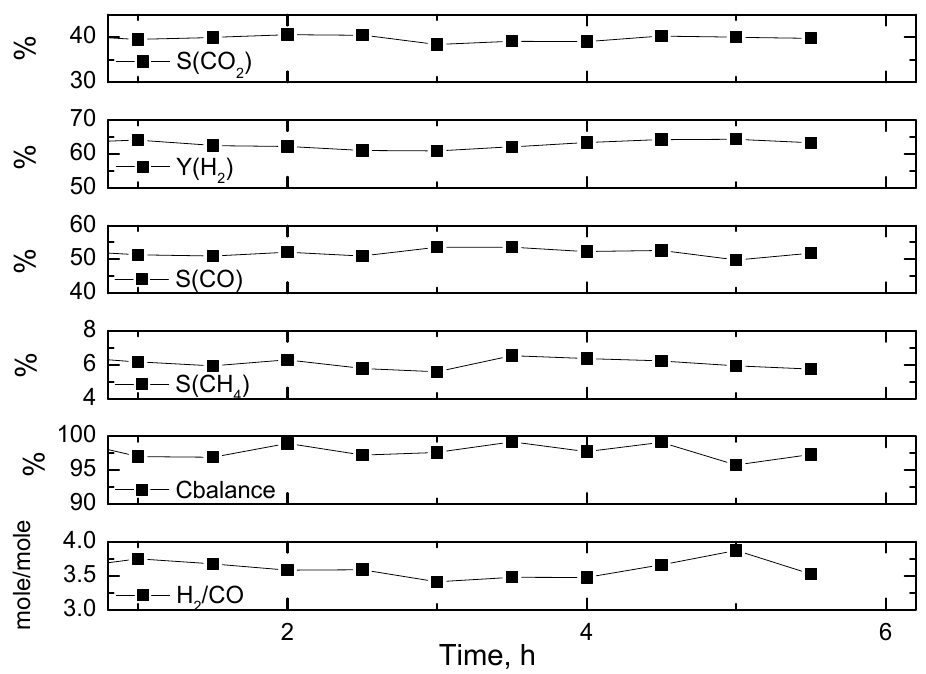
Figure 5. Time-on-stream test of NiPSCZ_LMRp catalyst in ethanol steam reforming at 600 °C. Study of samples after 6 h of reaction by transmission electron microscopy (Figure 6)